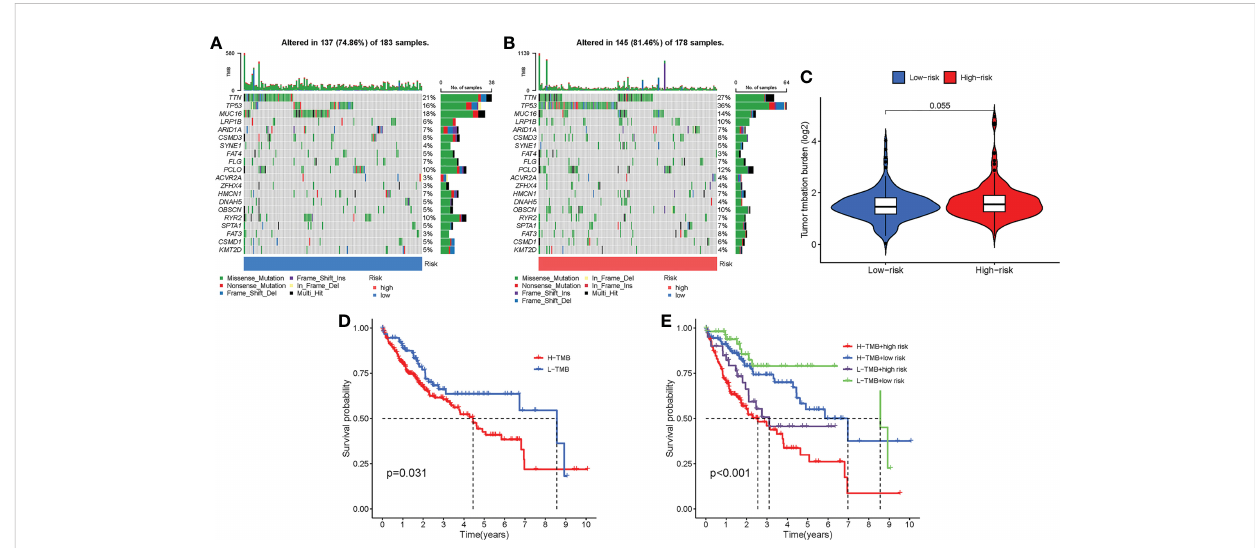
FIGURE 11 Mutation differences between the low-risk group and the high-risk group. (A) Mutation landscape in the low-risk group. (B) Mutation landscape in the high-risk group. (C) Differences in TMB between the two risk groups. (D) Survival analysis between patients with low TMB and patients with high TMB. (E) Survival analysis combining risk score and